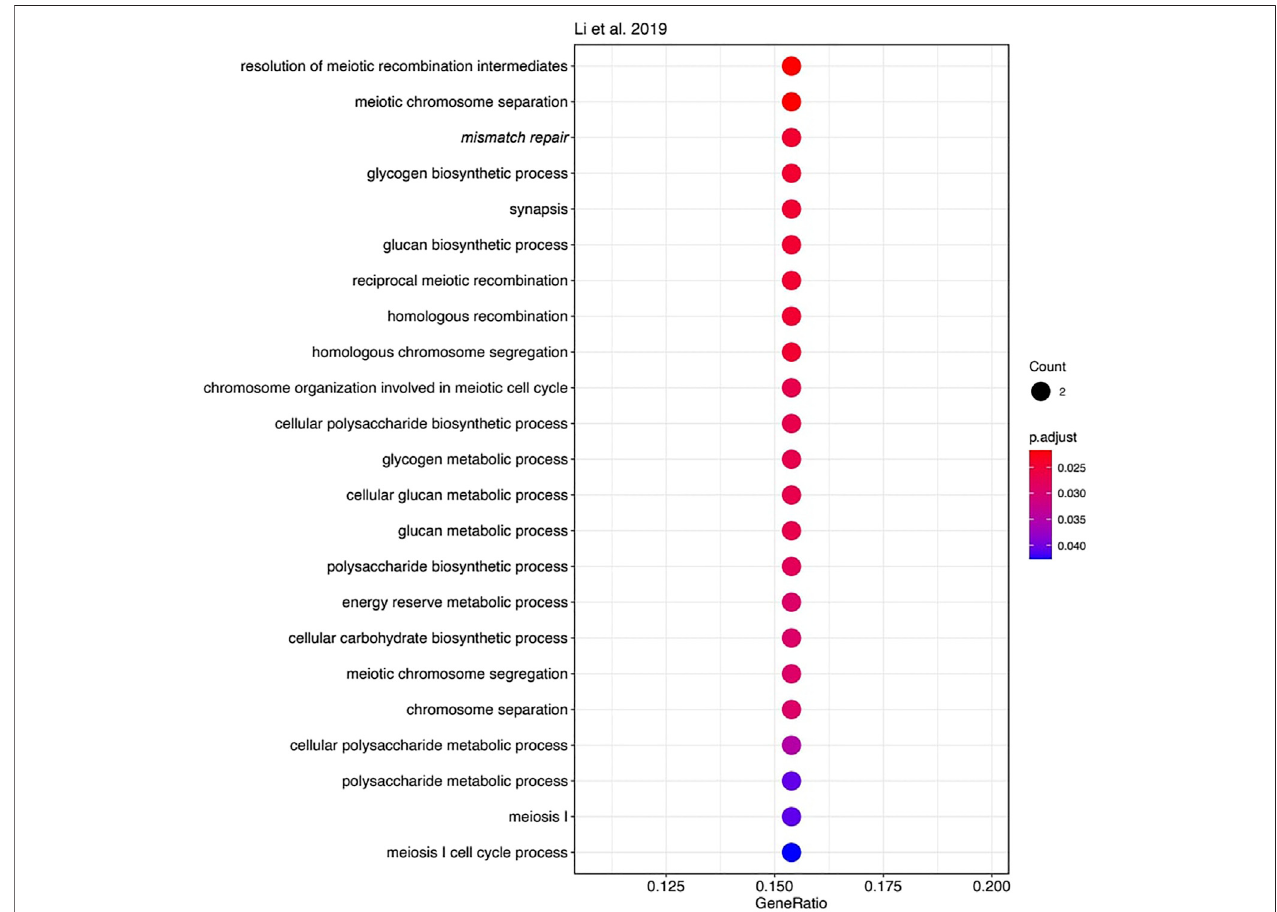
FIGURE 4 | Biological process GO terms for genes included in Li signature. Visualized using R package enrichplot (http://bioconductor.org/packages/release/ bioc/html/enrichplot.html). All terms passed Benjamini – Hochberg adjusted p -value threshold of 0.05.